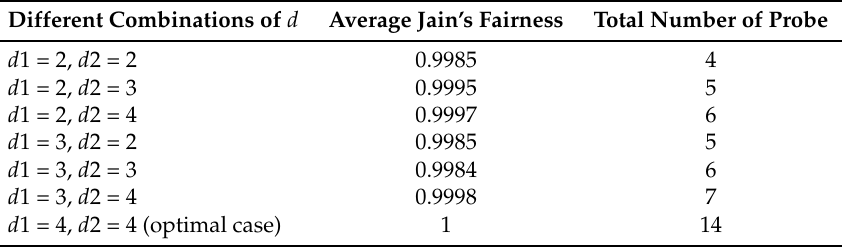
Table 3. Comparison of different d